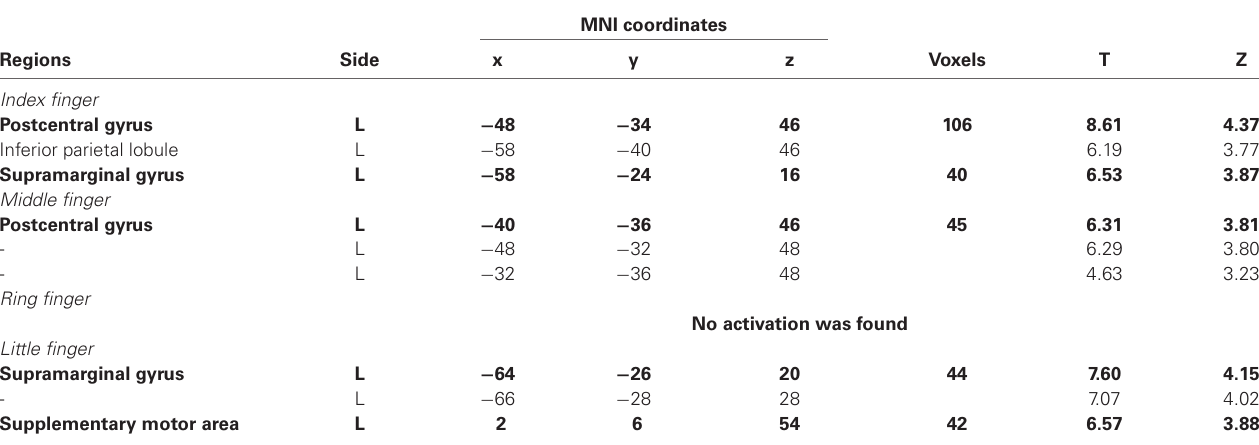
labels indicate sub-peak within the cluster named above. Table 3 | Activated clusters from contrasting anlysis (finger stimulation vs. no stimulation) using univariate group GLM ( p < 0.001 uncorrected, cluster size > 10)